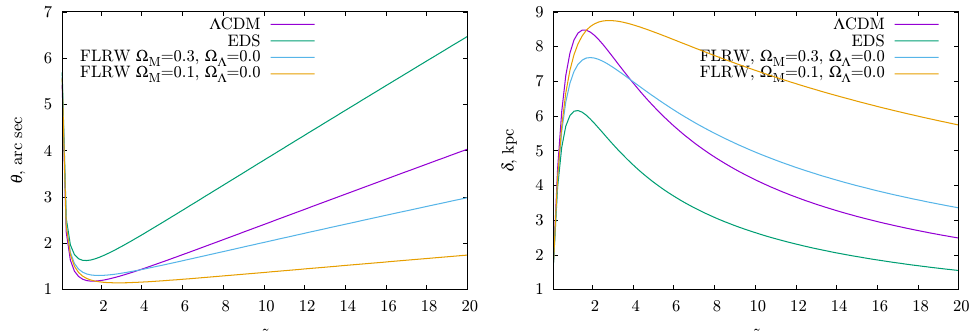
Figure 2. Angular diameter of a 10 kpc-size object ( left ) and the linear diameter δ of a one-arcsec-size object ( right ) as functions of redshift z , corresponding to various models within the expanding- universe framework (FLRW). The purple curves show the θ ( z ) relation for the standard Λ CDM model with Ω M = 0.3 and H 0 = 70.0 kms − 1 Mpc − 1 . The green curves correspond to the Einstein-de Sitter Universe ( Ω M , Ω Λ ) = ( 1,0 ) . The blue and yellow curves show θ ( z ) for two values of Ω M for FLRW models without dark